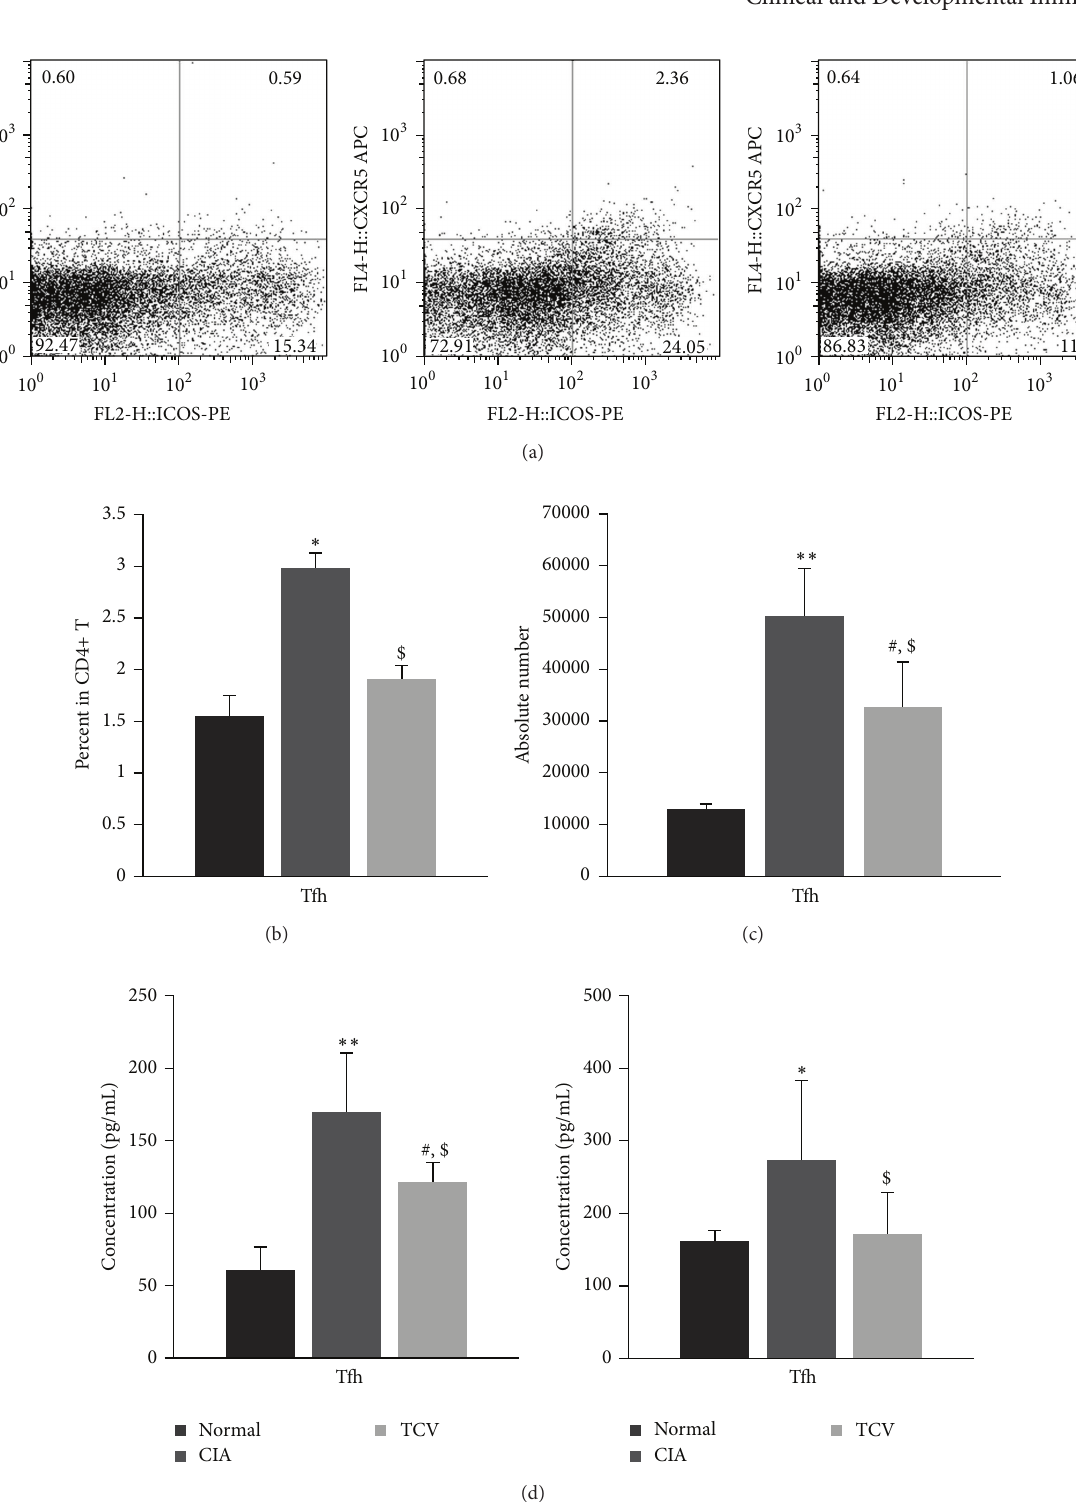
Figure 3: TCV influenced the frequency of Tfh cells and IL-21 in CIA mice. The three groups of mice were sacrificed at the peak of the disease. DLN MNCs were harvested, stained with antibodies for CD4, CXCR5, and ICOS, and analyzed by flow cytometry. (a)-(b) Flow cytometry results showed the percentage of Tfh cells in DLN CD4+ cells. (c) Results showed the absolute number of Th1/Th17 cells in DLN. (d) Heart blood was collected and the serum was isolated by centrifuge. Spleen MNCs were prepared and incubated (5 × 10 5 cells/well) in the absence and presence of heat-inactivated CII (20 𝜇 g/mL) for 48h and the supernatants were collected. The levels of IL-21 were determined using ELISA. Concentration of IL-21 in sera (left) and supernatants of cell culture (right). Data are represented as means ± SD ( 𝑛 = 10 mice/group). Data are representative of 5 separate experiments with similar results. ∗ 𝑃 < 0.05 , ∗∗ 𝑃 < 0.01 , CIA versus normal group. # 𝑃 < 0.05 , TCV versus normal group. $ 𝑃 < 0.05 , TCV versus CIA